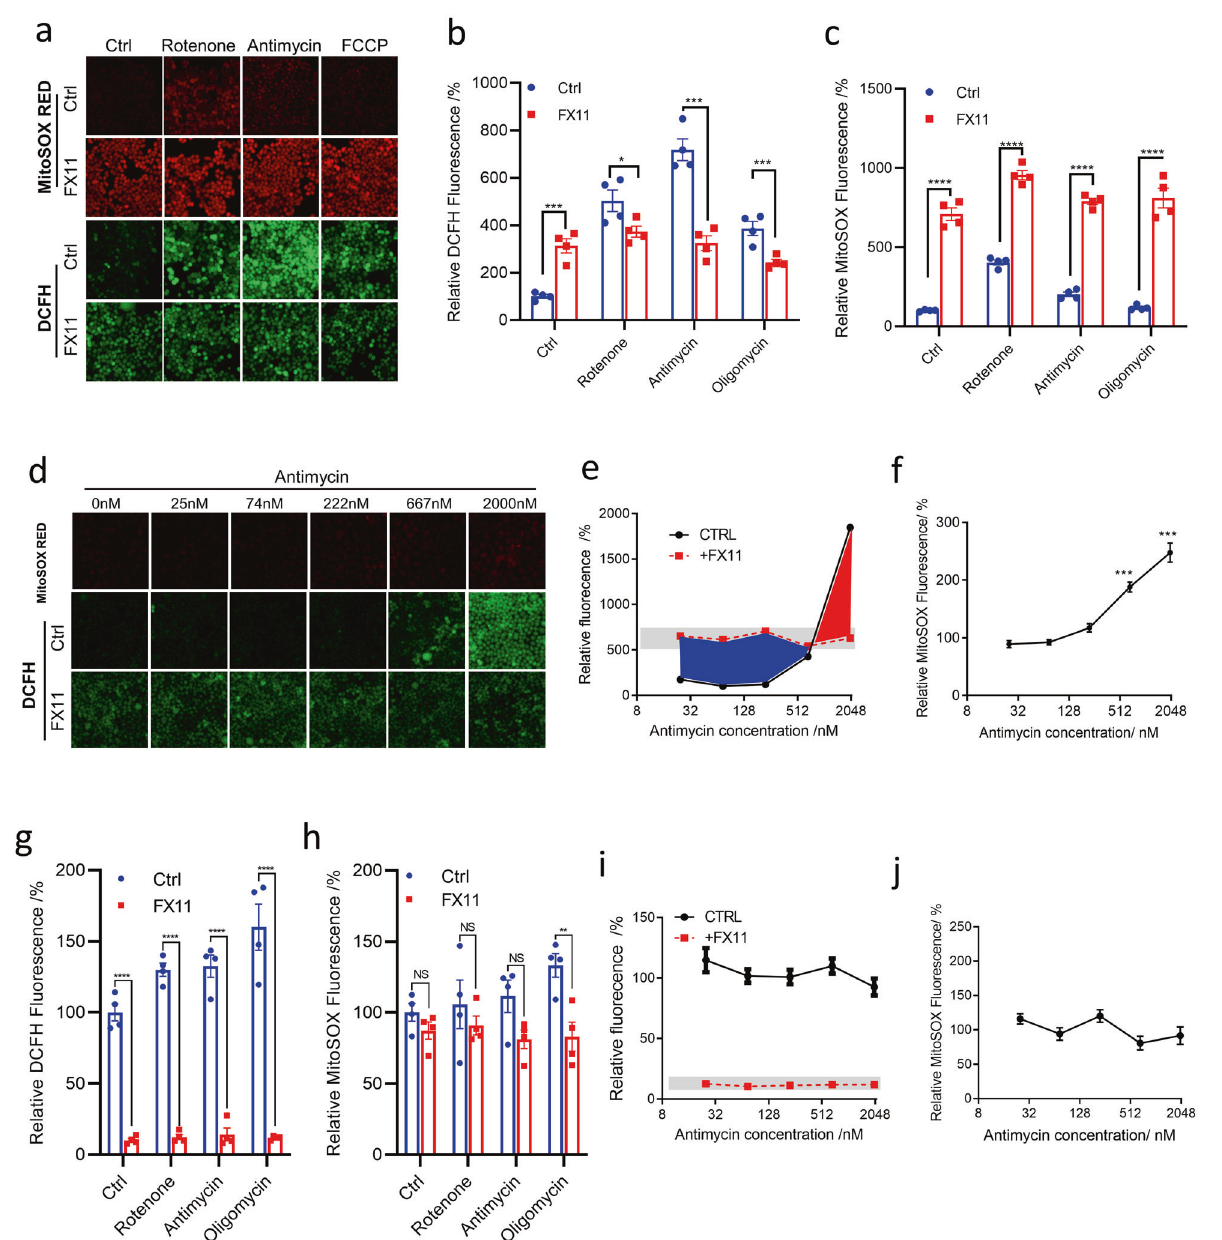
Fig. 4 Demonstration of dominant antioxidative and dominant pro-oxidative activity of LDH in HeLa and HeLa/ ρ 0 cells. a – d HeLa cells; e-g, HeLa/ ρ 0 cells). a Rotenone-, antimycin-, or oligomycin-induced production of mitochondrial ROS/superoxide (MitoSOX ™ Red) and total cellular ROS (DCFH) in HeLa with or without FX11. Cells were treated with 1 µM rotenone, antimycin, or oligomycin in serum-free RPMI-1640 medium for 2 h and loaded with DCFH-DA or MitoSOX Red with or without 15 µM FX11 in the same medium containing ETC inhibitors. Fluorescence signals were captured by confocal microscope imaging. b Total DCFH fl uorescence signal of single cells from experiment ( a ) were calculated for analysis. c Total MitoSOX Red fl uorescence signal of single cells from experiment ( a ) were calculated for analysis. d Antimycin showed concentration-dependent induction of mitochondrial ROS/superoxide (MitoSOX Red) and total cellular ROS (DCFH) in HeLa with or without FX11. e Total DCFH fl uorescence signal of single cells from experiment ( d ) were calculated for analysis. The blue and red areas represent the conversion from dominant antioxidative to dominant prooxidant activity of LDH or vice versa. The intersection point represents equal antioxidative and pro-oxidative activity of LDH. f Total MitoSOX Red fl uorescence signal of single cells from experiment ( d ) were calculated for analysis. g The statistical data of the mitochondrial ETC modulators did not signi fi cantly change total cellular ROS (DCFH) in HeLa/ ρ 0 with or without FX11. h The statistical data of the mitochondrial ETC modulators did not signi fi cantly change mitochondrial ROS/ superoxide (MitoSOX ™ Red) in HeLa/ ρ 0 with or without FX11. i The statistical data of a serial concentration of antimycin showed no induction of total cellular ROS (DCFH) in HeLa with or without FX11. j The statistical data of a serial concentration of antimycin showed no induction of mitochondrial ROS/superoxide (MitoSOX ™ Red) in HeLa cells. Data were con fi rmed by at least three independent experiments and expressed as mean ± SEM. The experimental details are described in Materials and Methods